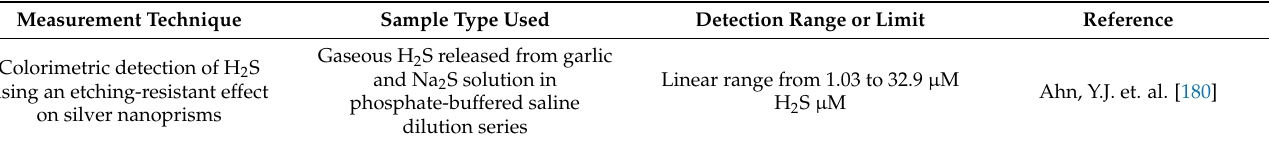
Table 2. Various hydrogen sulfide detection approaches in different phases of matter samples with potential clinical utility. Abbreviations: ppb—parts per billion; ppm—parts per million; VSC—volatile sulfur compounds; LOD—limit of detection; iv—intravenous; FMS—frequency